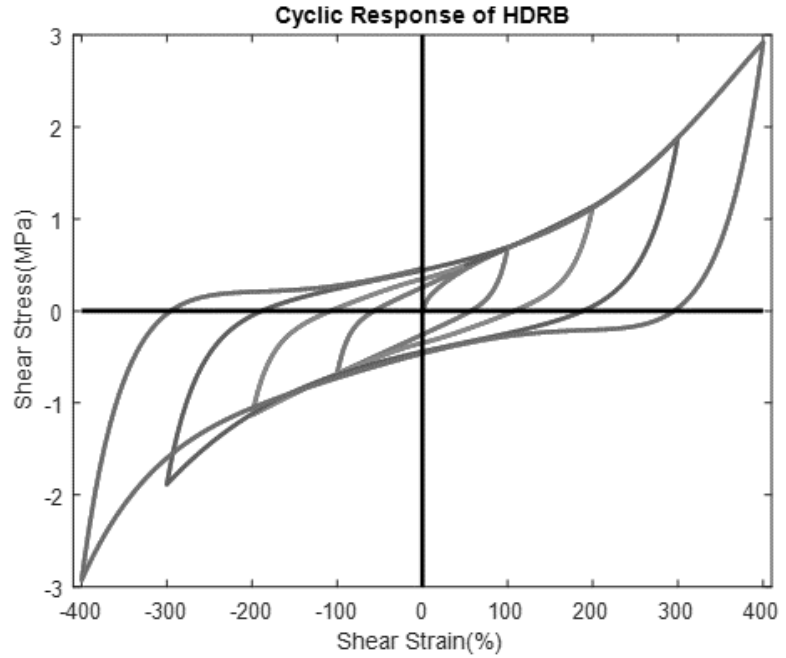
Figure 5. Cyclic response of HDRB obtained from a phenomenological multi-spring model.